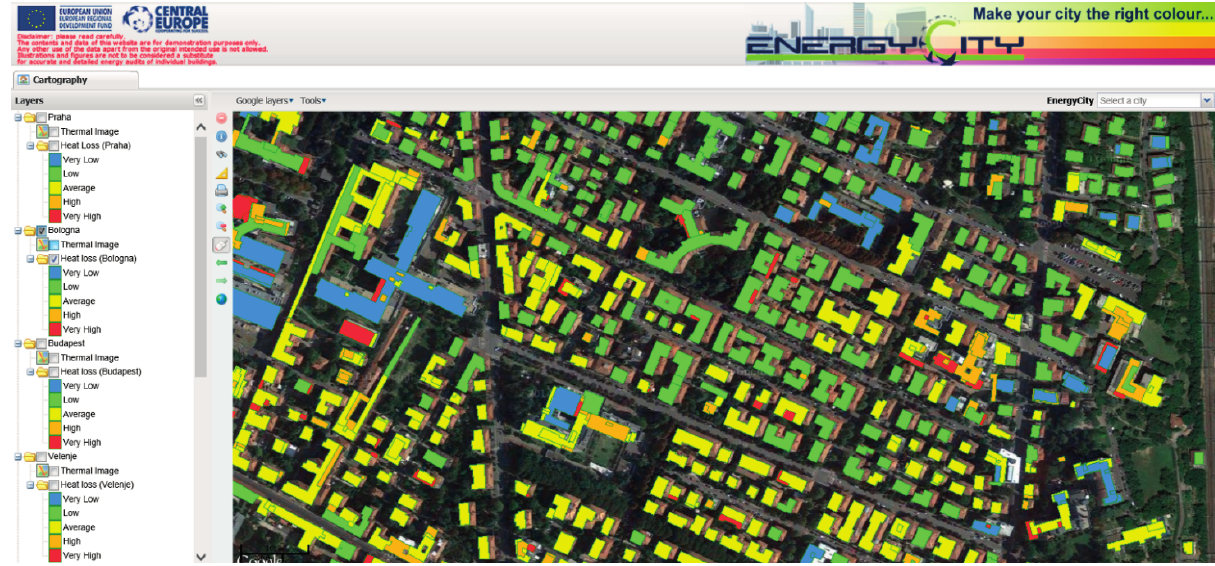
Figure 9. Energy classification of buildings in the spatial decision support system (SDSS) tool developed within the EnergyCity